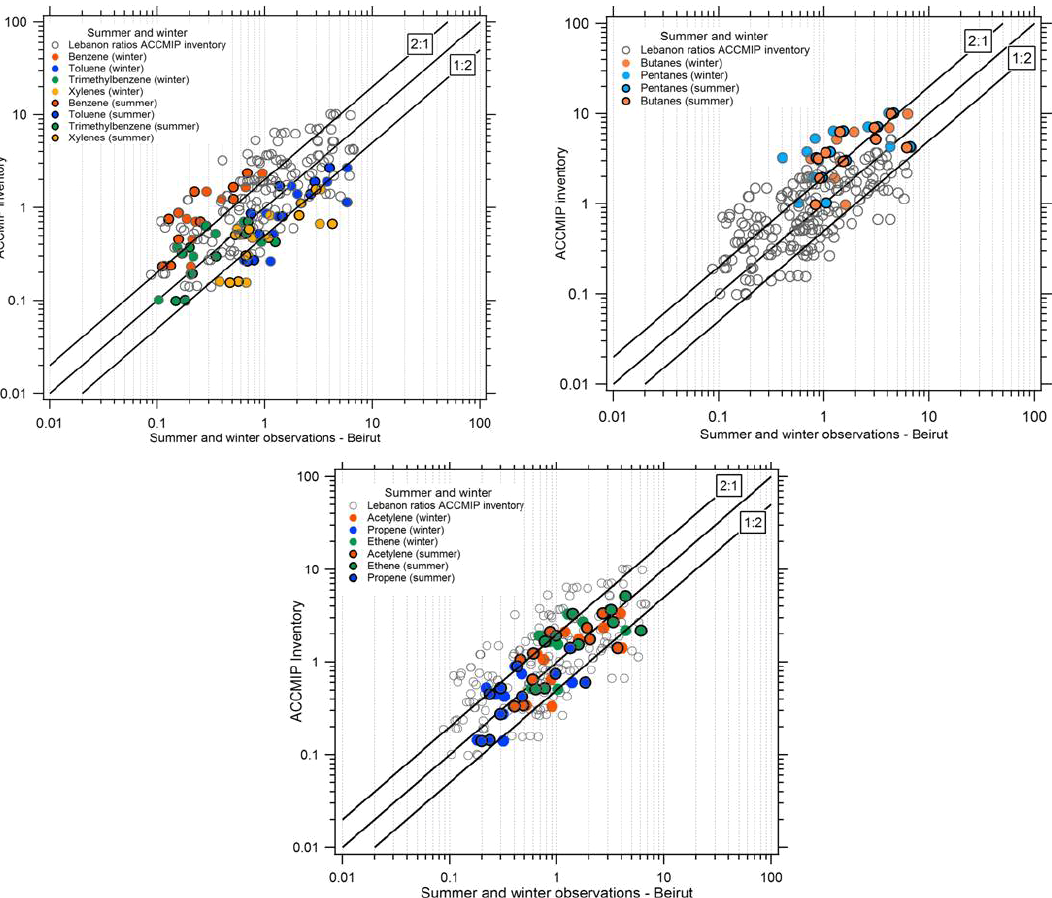
Figure 9. Comparison of the emission ratios of NMVOC vs. NMVOC i from ACCMIP to the measured ones, in summer and in winter, for all the anthropogenic sectors, for all data of all compound classes (in grey dots), and for a given NMVOC (coloured dots).